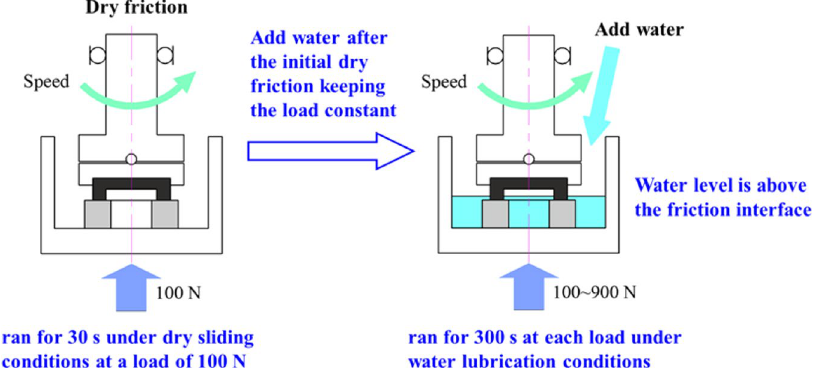
Figure 8. Experiment procedures: ran for 30 s under dry sliding conditions at a load of 100 N, then adding water into the liquid pool until the water level is above the friction interface, and continued running for 300